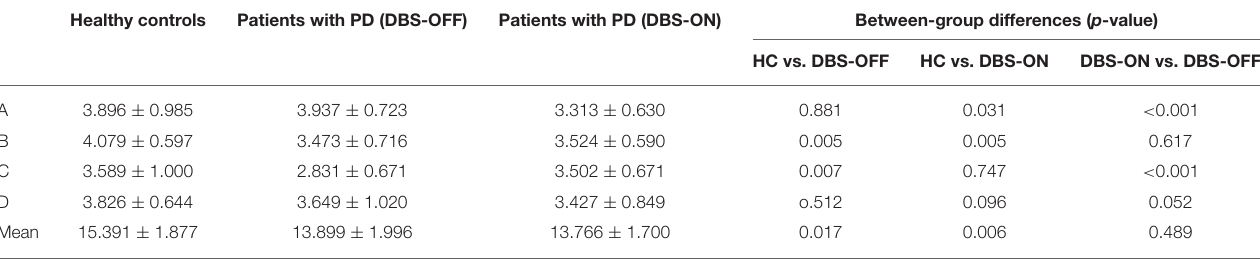
TABLE 2 | Occurrence per second of microstate classes A to D and mean of three groups, and results from the comparison between groups with an independent samples t -test and a paired samples t -test. Healthy controls